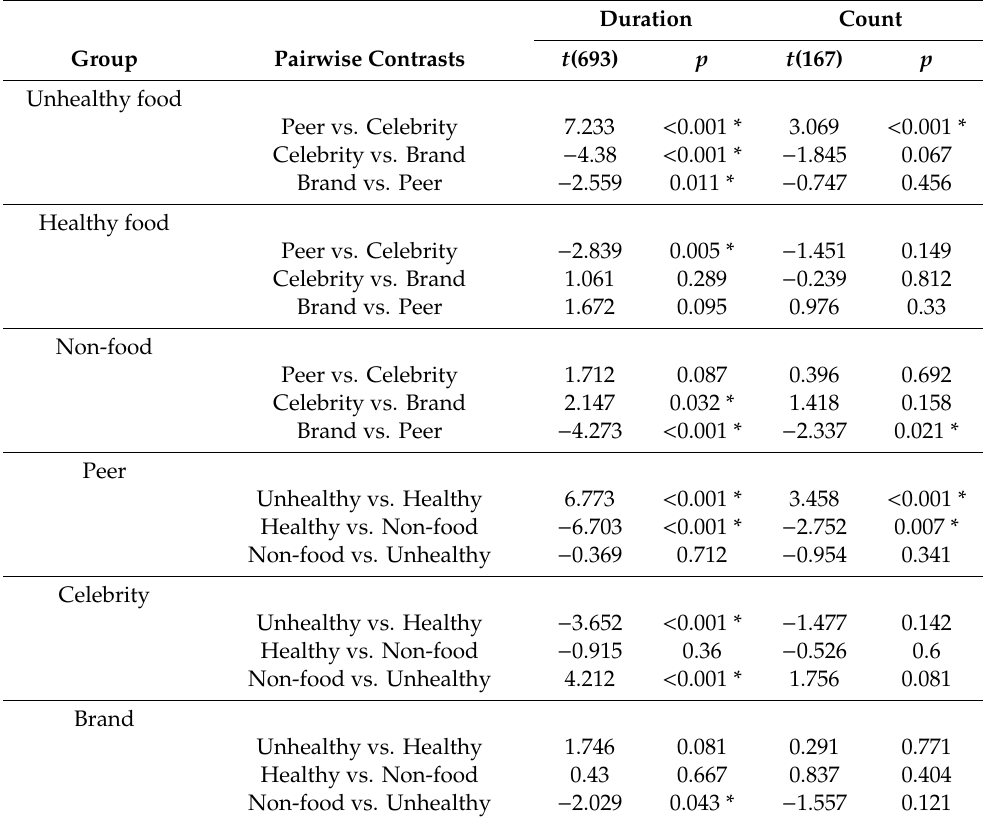
Table 8. Fixation count and duration: Results of pairwise